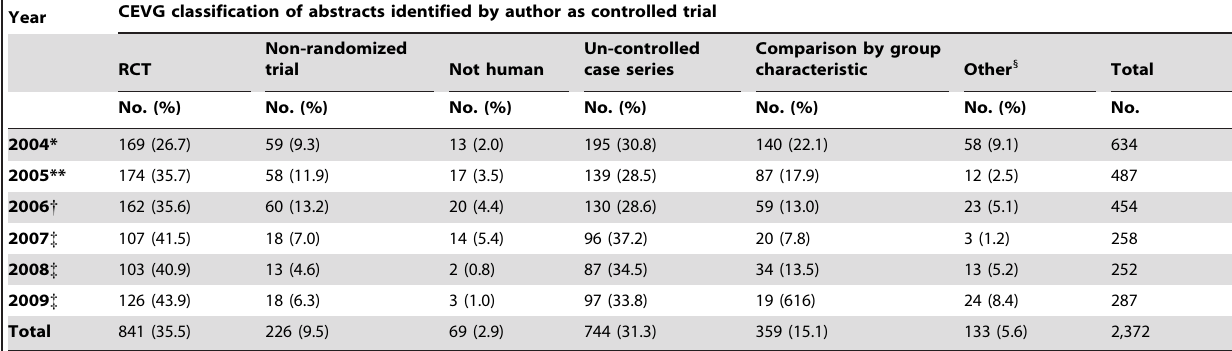
Table 2. Abstracts identified by author as controlled trial by study design and year of presentation at ARVO.